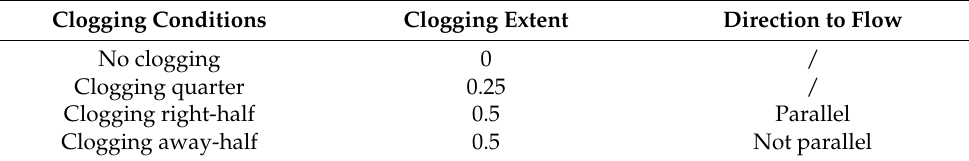
Table 2. Incoming critical state water depth under different clogging